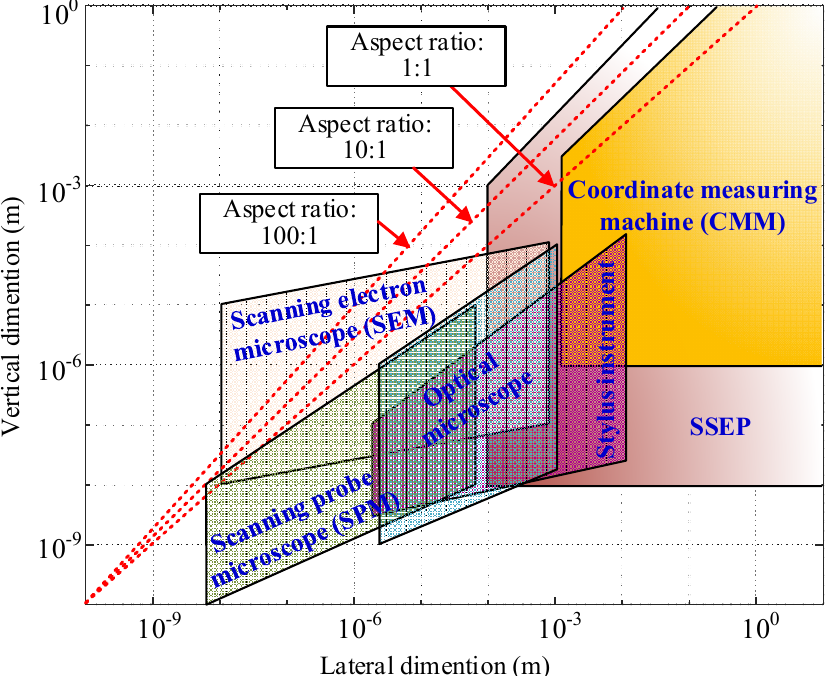
Figure 11. Measurement methods for dimensional micro- and nanometrology (inspired by Ref. [28], in this figure the “CMM” refers to a coordinate measuring machine (CMM) with traditional probes, and “SSEP” refers to SSEP used with CMM).